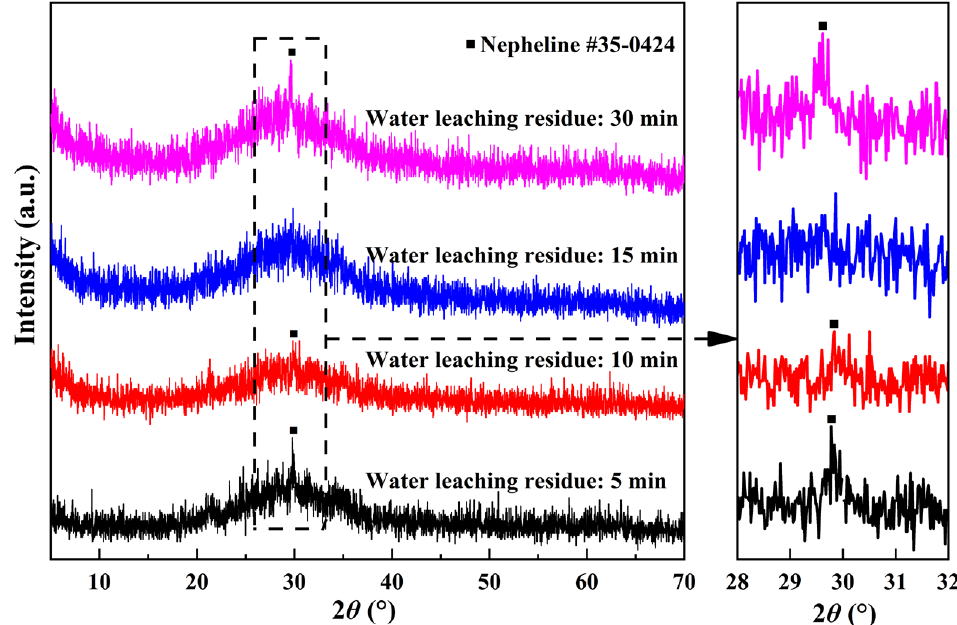
Figure 6. XRD patterns of water leaching residues.